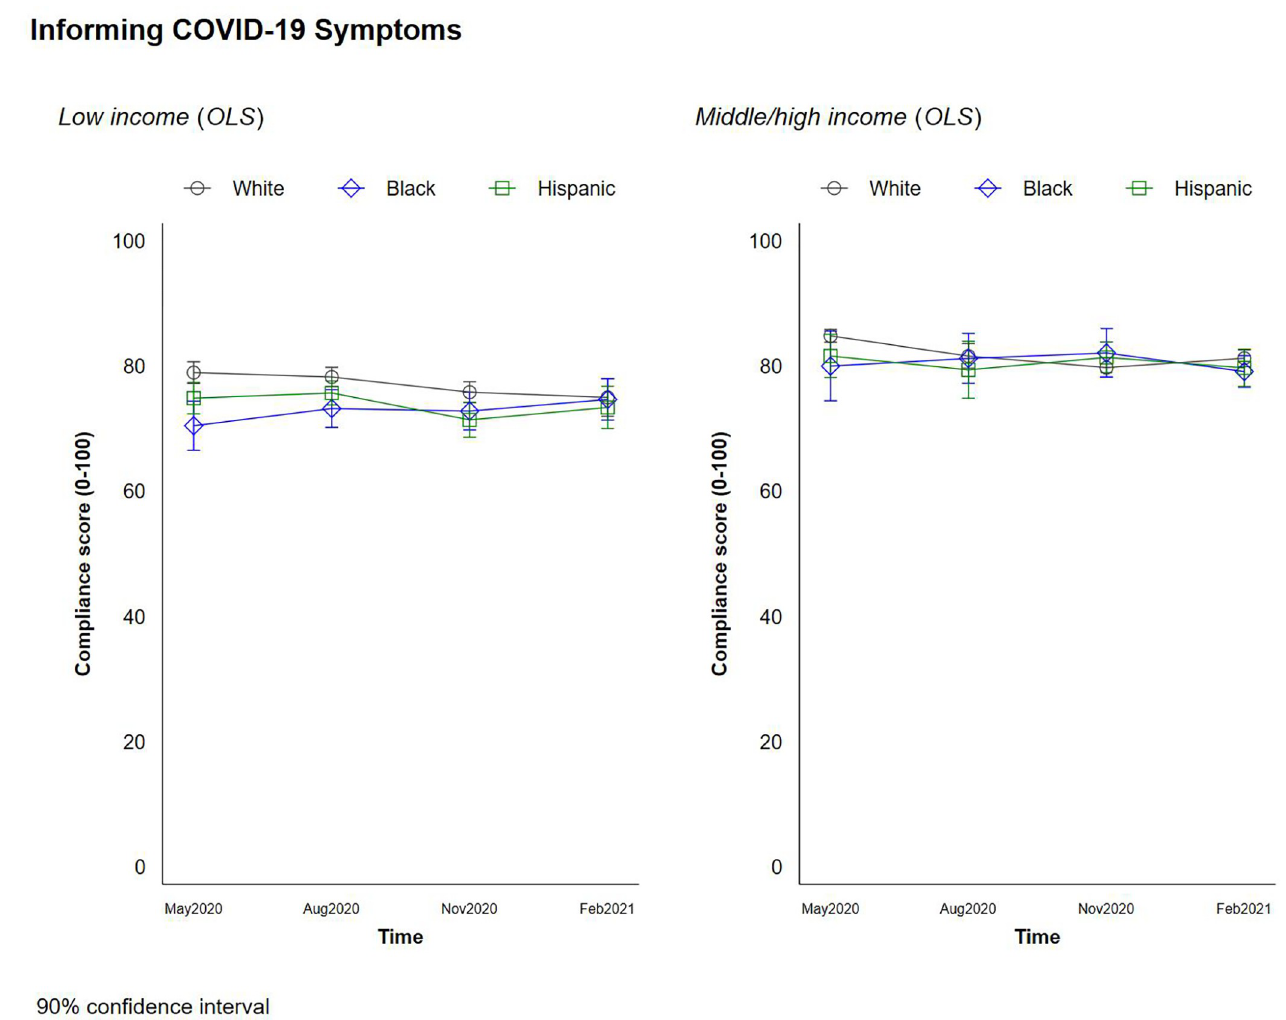
Fig 9. Changes in social distancing behaviors by race and income–informing one’s COVID-19 related